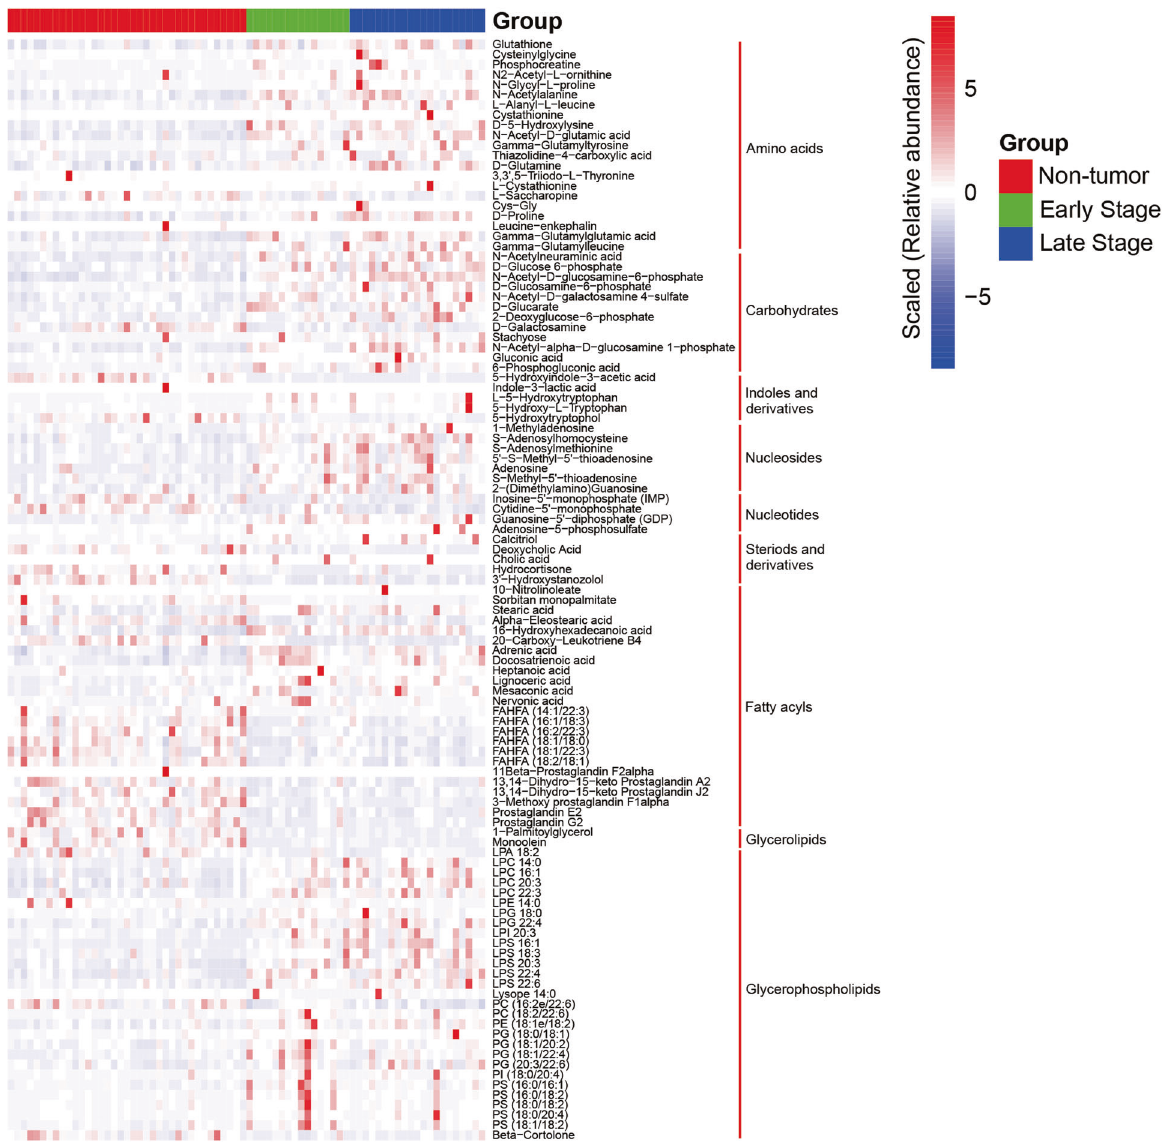
Fig. 8 The heat map shows the association between metabolites and tumor stage. The differences in metabolites among non-tumor tissues ( n = 37), early-stage (stage I – II, n = 16) and late-stage gastric tumor tissues (stage III, n = 21) were displayed. The heat map shows the scaled relative abundance (Lg) of 109